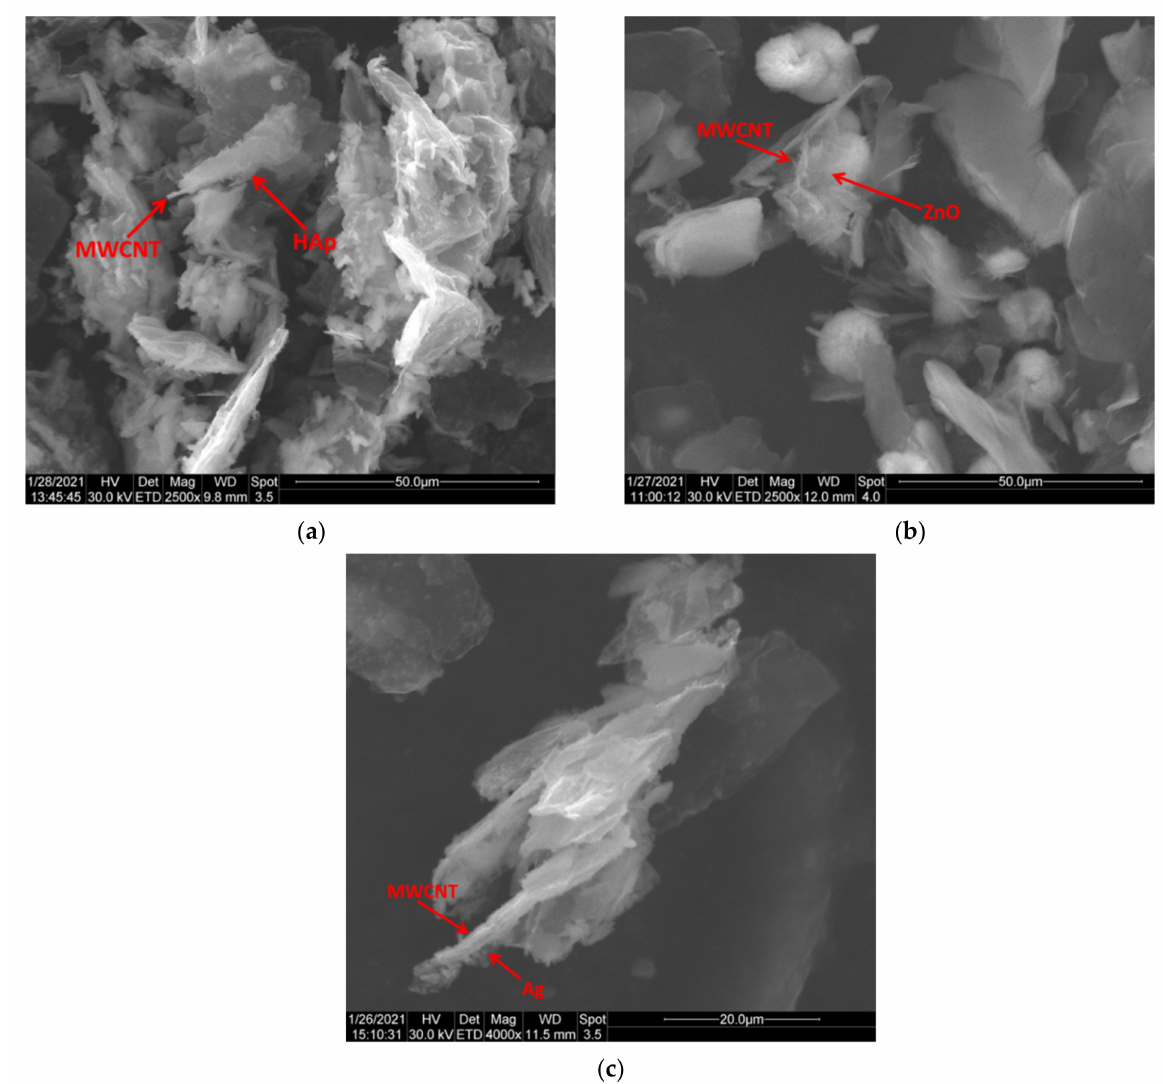
Figure 7. SEM images illustrating the decoration of MWCNTs with HAp ( a ), ZnO ( b ) and Ag ( c ) NPs.